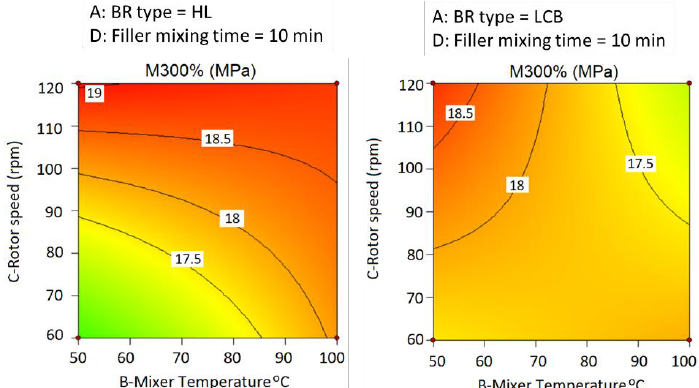
Figure 9. The e ff ect of rotor speed and filler mixing time on M300% in rubber compounds containing HL-BR and LCB-BR .